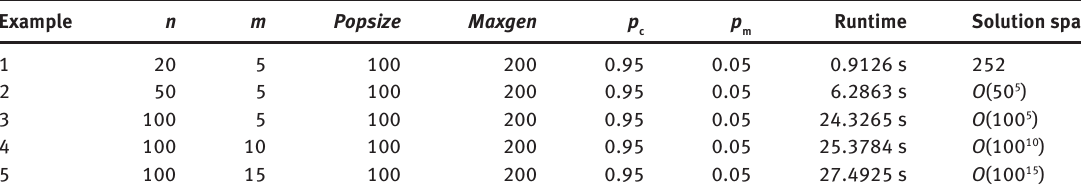
Table 4: Simulation